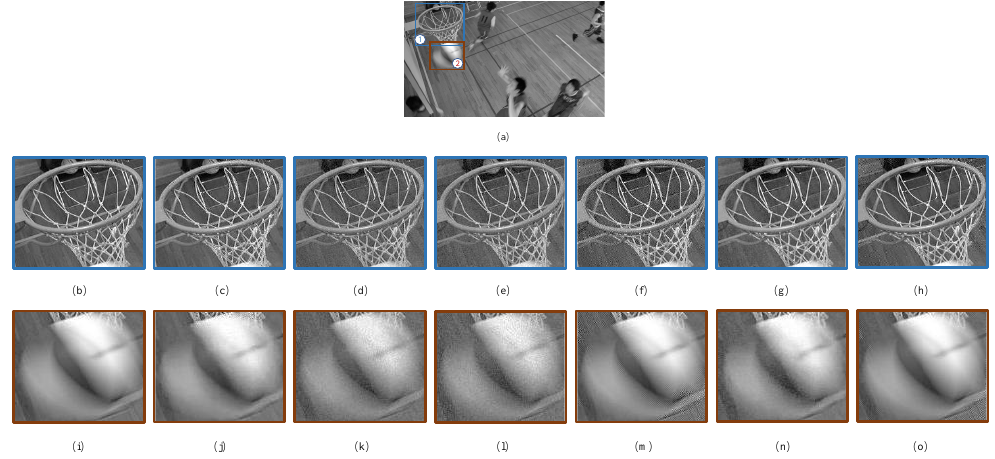
Figure 17. The 70th frame of the “Basketball Drill” sequence. ( a ) The original image; ( b – h ) are the enlarged images of the sub-region (cid:172) ; ( i – o ) are the enlarged images of the sub-region (cid:173) . In turn, they are the original patch and the distorted versions processed by Bae 2017, Zeng 2019, Wang 2020, Xing 2021, Li 2022 and the proposed JND model, respectively. The PSNR values of the distorted versions are 27.24 dB, 32.12 dB, 30.63 dB, 26.16 dB, 33.42 dB and 25.42 dB, respectively. Table 3. Performance Comparison of Different Combinations of